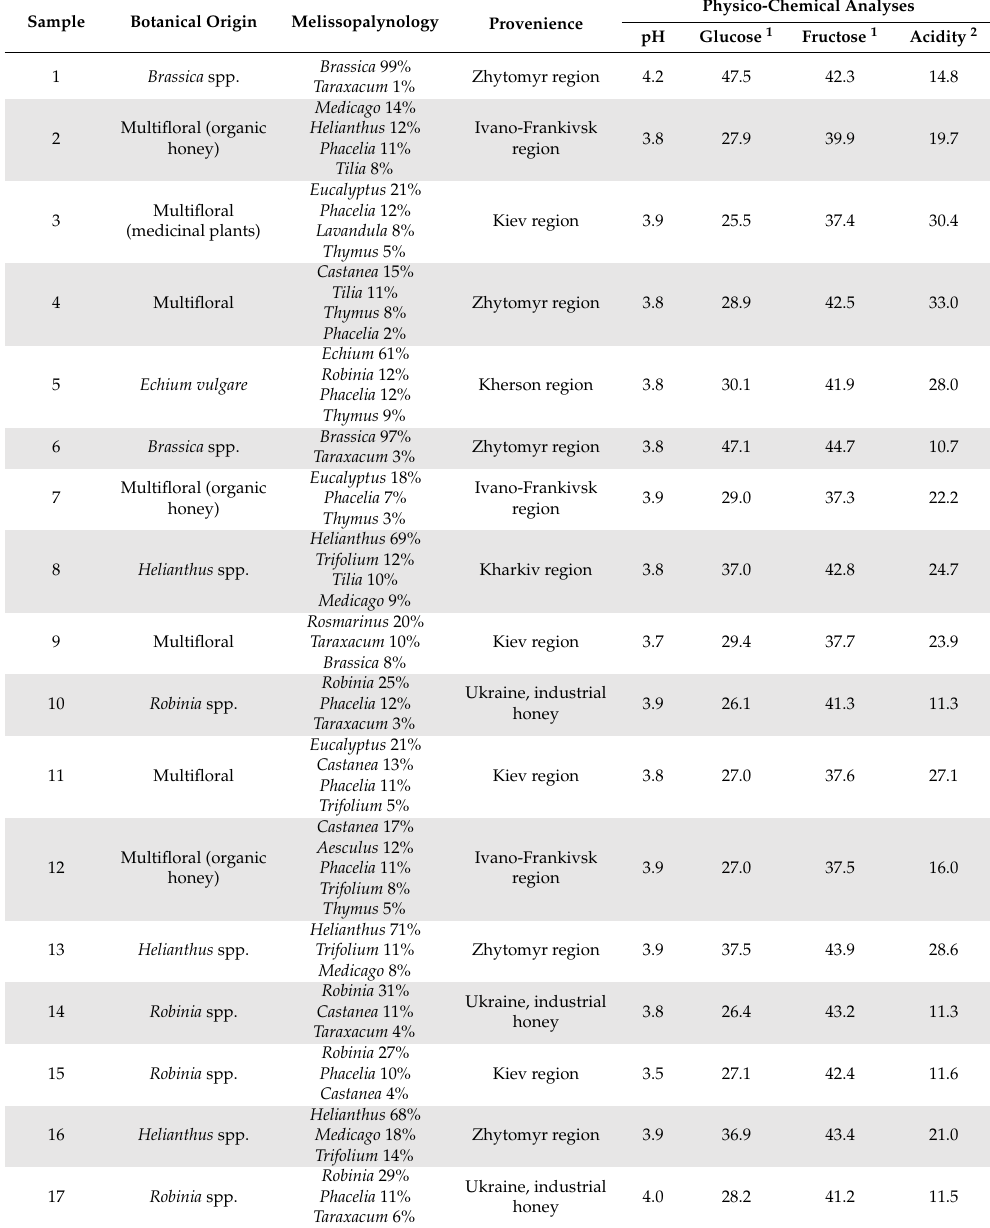
Table 1. Characteristic of honey samples